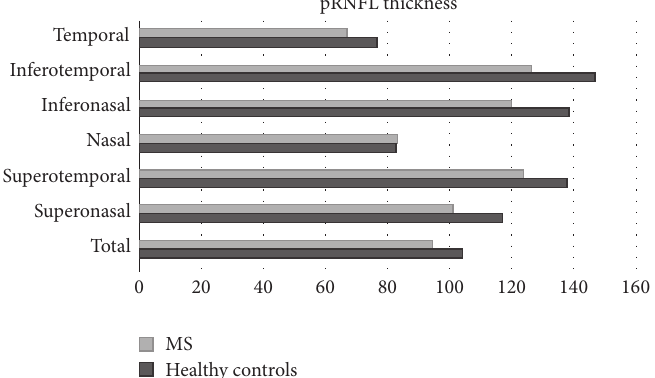
Figure 2: Mean peripapillary retinal nerve fiber layer (pRNFL) thickness of 100 multiple sclerosis (MS) patients compared with 97 healthy controls, as measured with optical coherence tomography. The peripapillary area is divided into 6 different sectors (superonasal, superotemporal, nasal, inferonasal, inferotemporal, and temporal) and average thickness. All measurements except nasal thickness were found to be significantly reduced in MS patients compared to controls (Garcia-Martin et al., data not